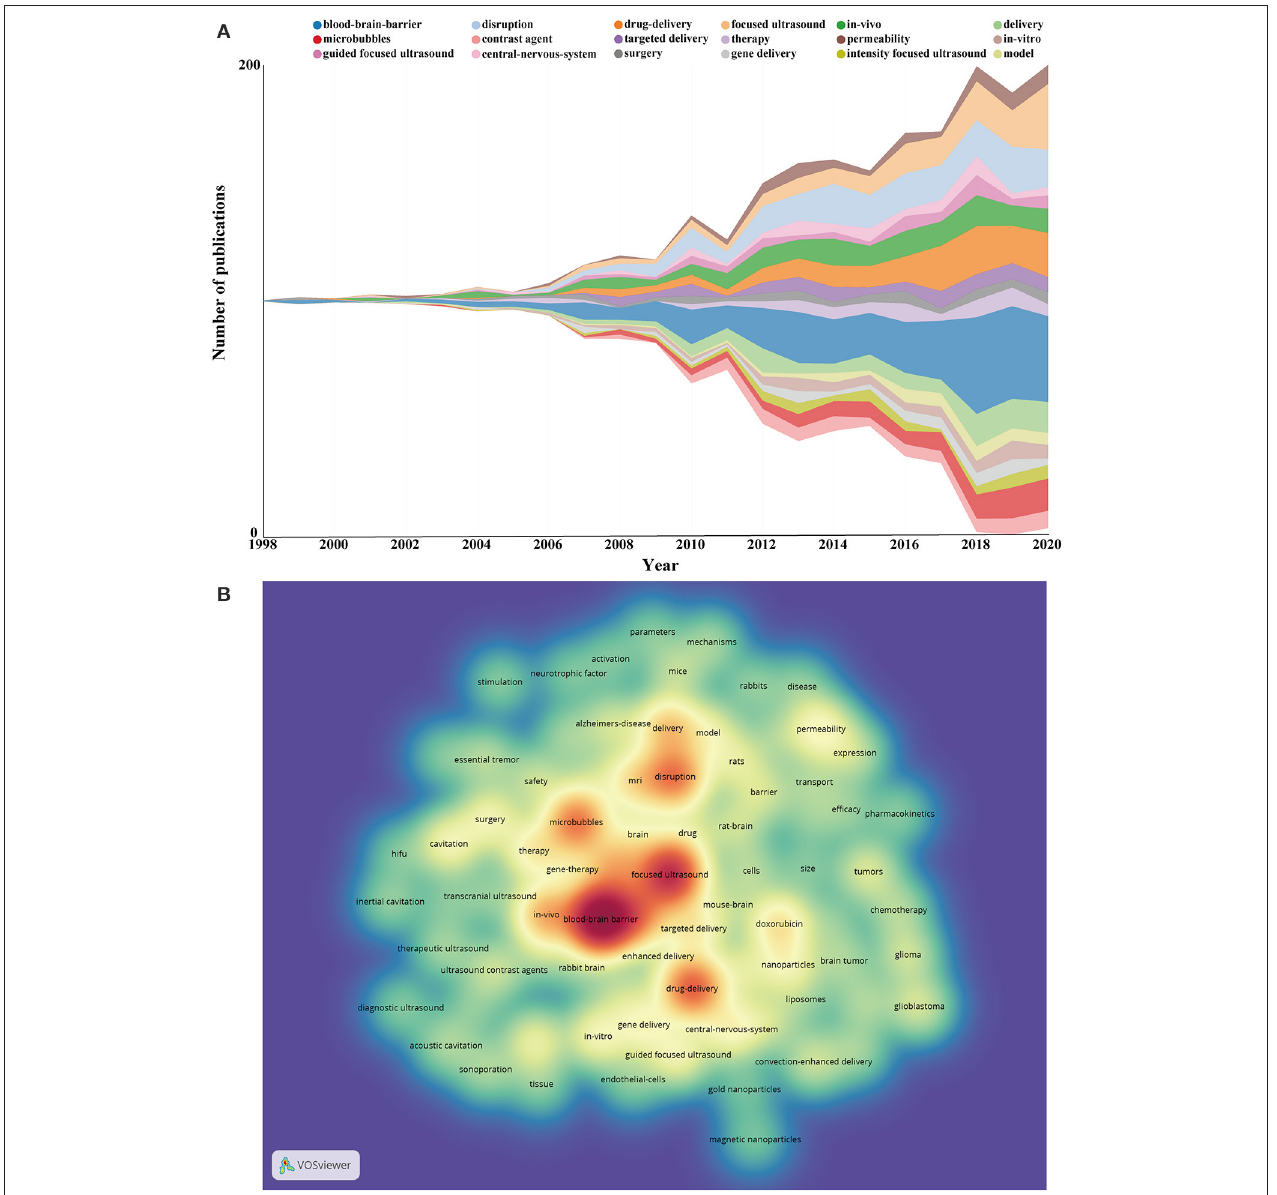
FIGURE 8 | (A) The change pattern of annual keyword appearance frequency from 1998 to 2020. (B) A density visualization map was drawn with 82 included keywords by using VOS